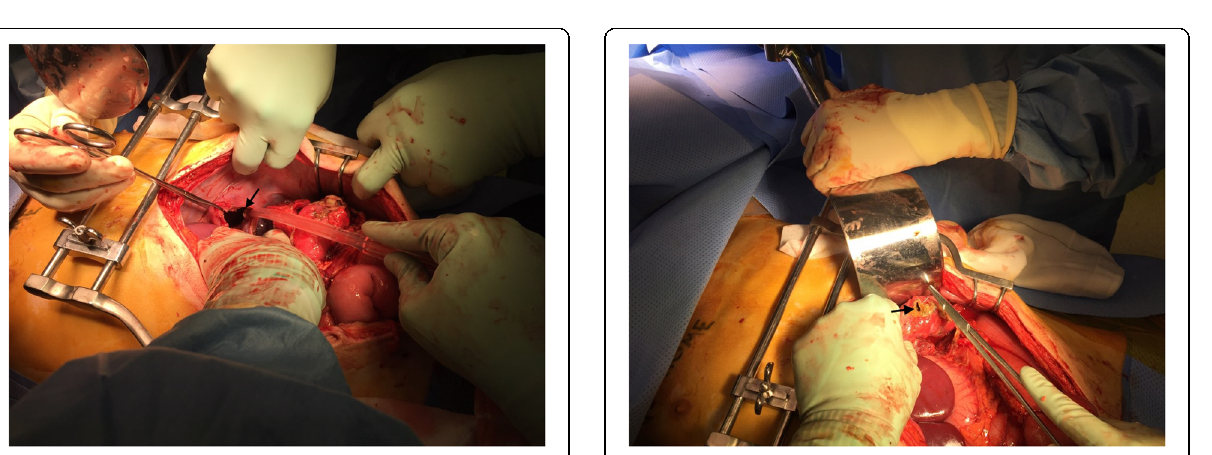
Fig. 3 Intraoperative view of the reduced splenic flexure. Black arrow points to the colonic